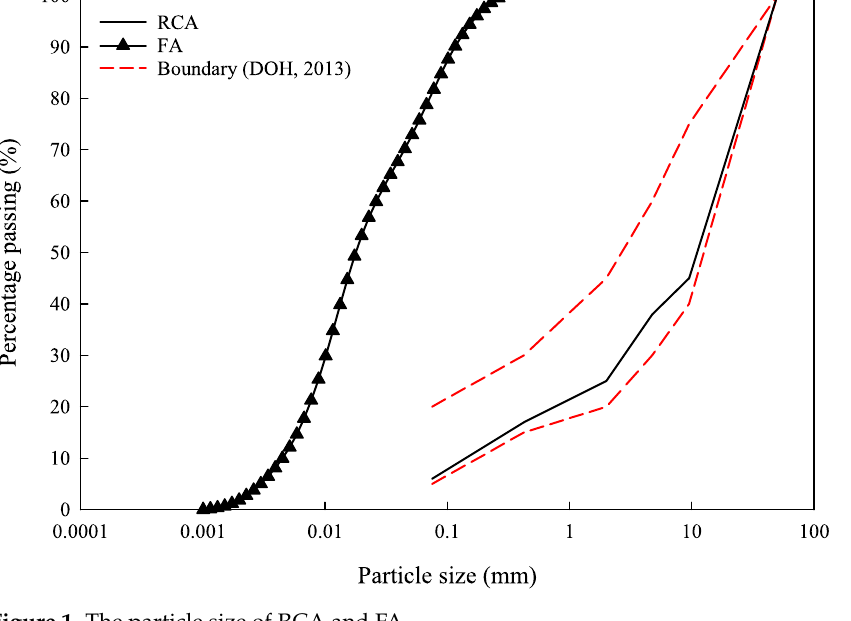
Figure 1. The particle size of RCA and FA. Table 1. Chemical composition of FA.